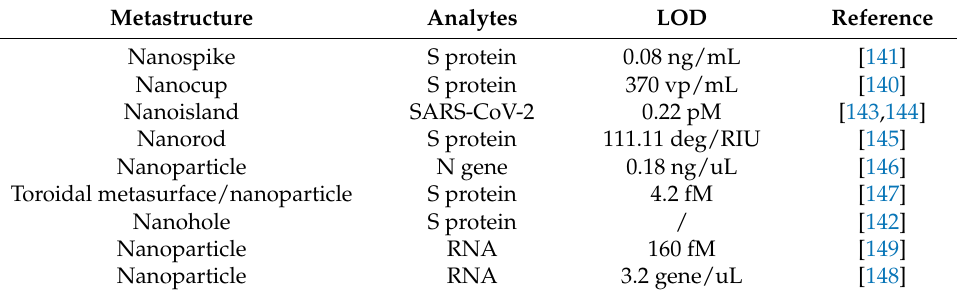
Table 2. Performance of COVID-19 based on metasurfaces. Metastructure Analytes LOD Reference Nanospike S protein Nanocup S protein